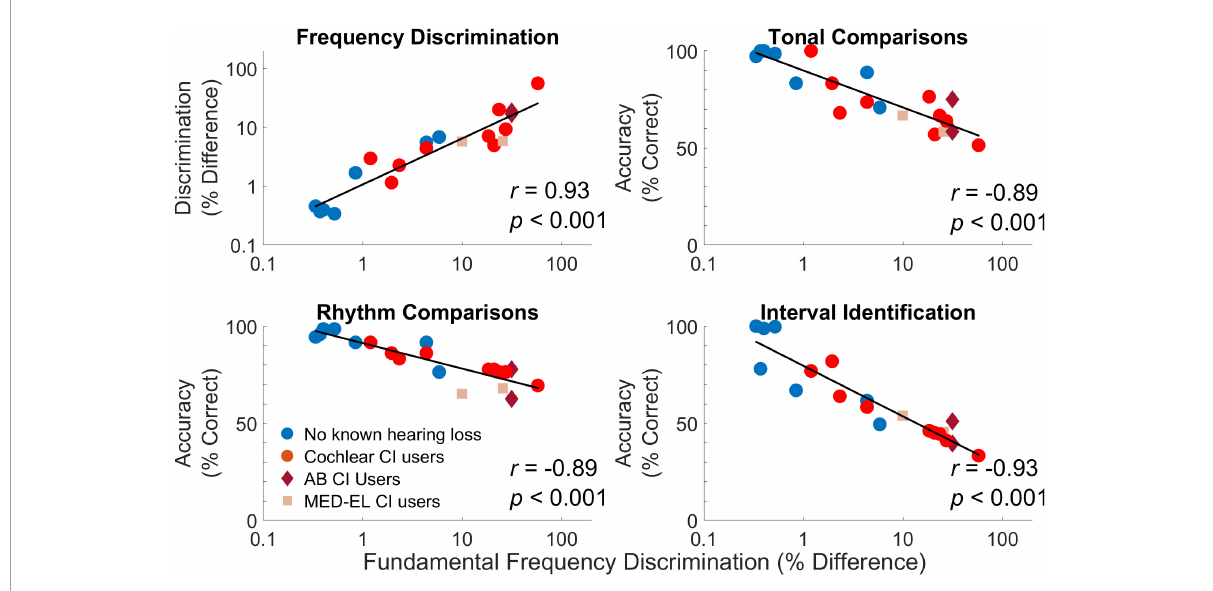
FIGURE7 Comparisons of individual results from different procedures based on averages across conditions. For each comparison, each symbol represents the average measure for each individual participant averaged across conditions and repetitions. Individual thresholds for cochlear implant users with implants from Cochlear Corporation are represented with a circle (red), Advanced Bionics with a diamond (dark red), and MED-EL with a square (light